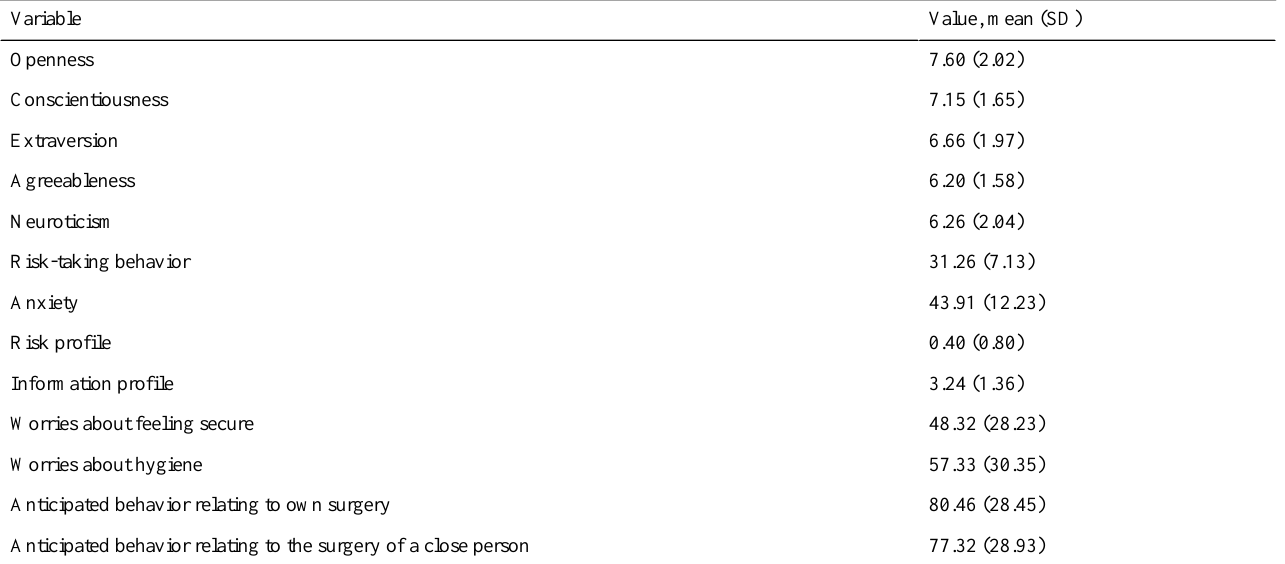
Table 3. Mean and SD values of